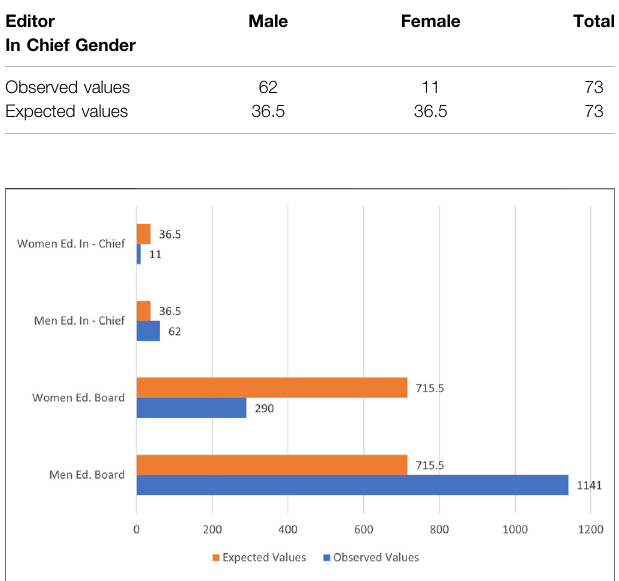
FIGURE 6 | Total observed and expected values by gender of the composition of the editorial board and editor(s)-in-chief.